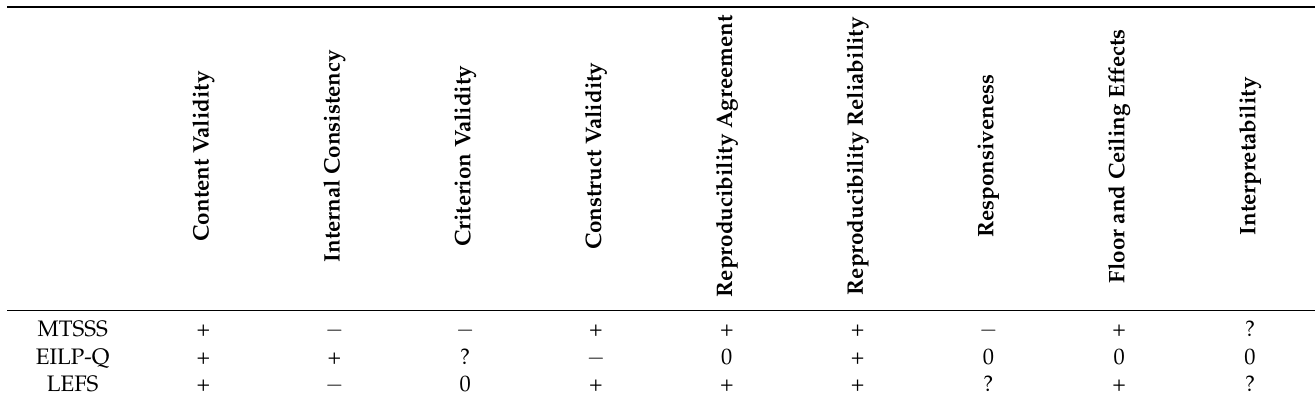
Table 2. Summary of the assessment of the measurement properties of the specific questionnaires described by Terwee et al.